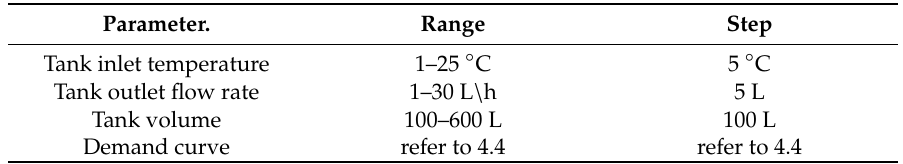
Table 2. Range of variation of